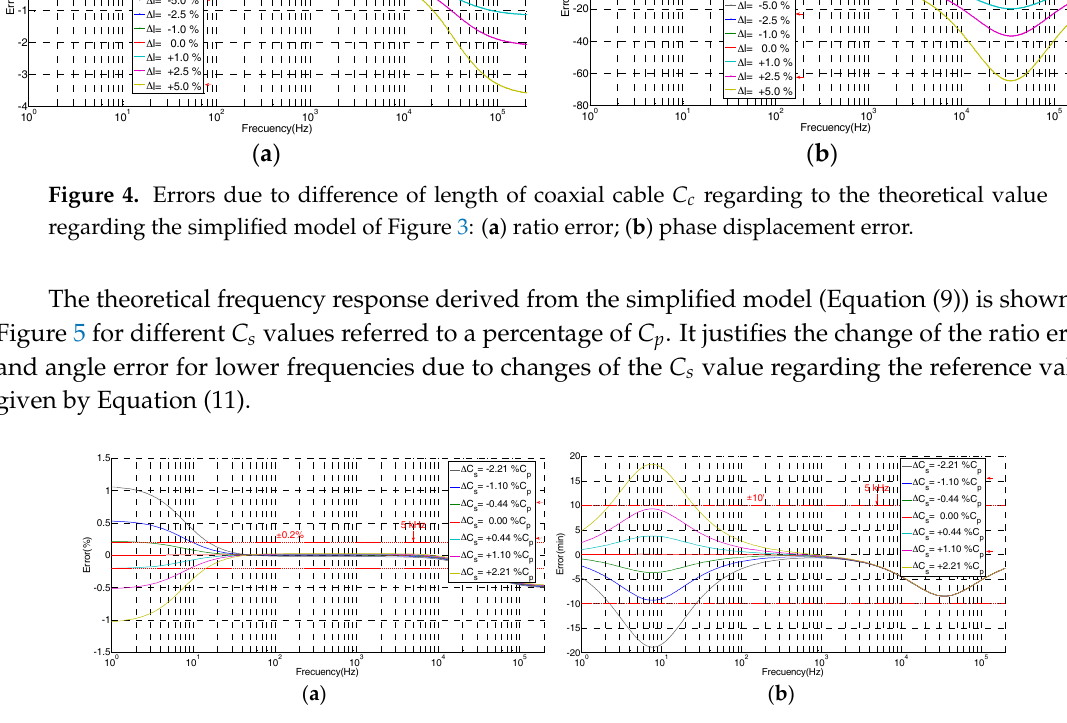
phase displacement error. ( b )